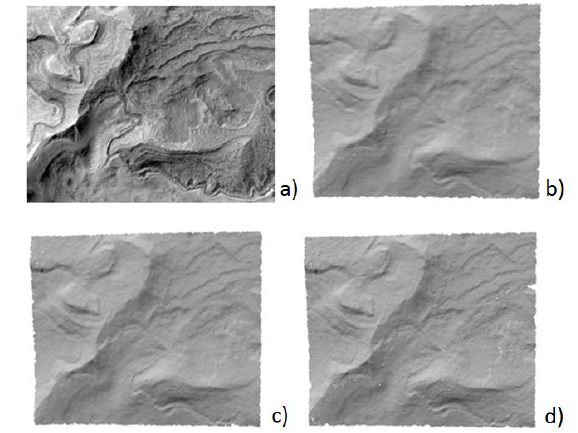
Figure 6 – Enlargement of DTM generation results in the central patch of Area01 (about 350 x 300 m): a) original image; b) reference DTM; c) ASP DTM; d) DM DTM